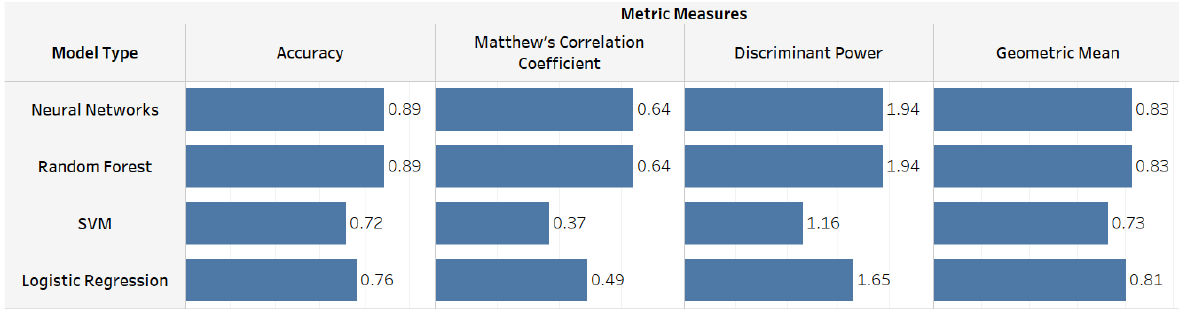
Figure 6. Performance metric results that measure the ability of each ML model algorithm to distinguish PAD.